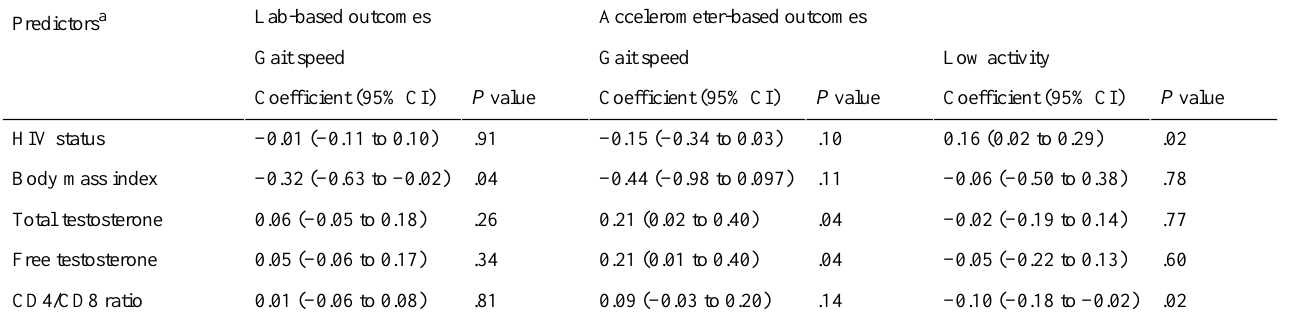
Table 4. Univariate linear regression models for activity